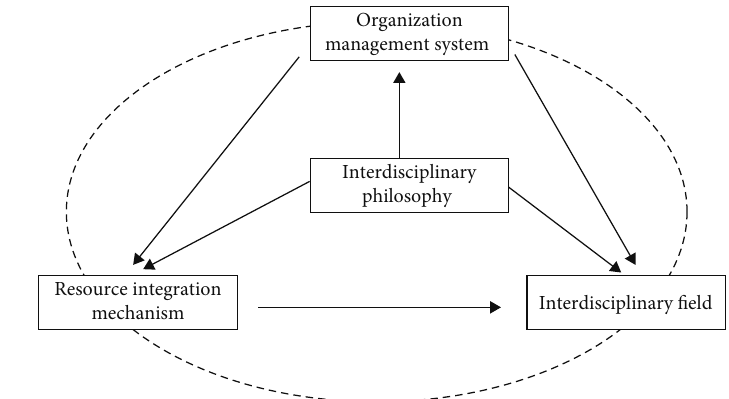
Figure 9: The relationship between factors involved in interdisciplinary education